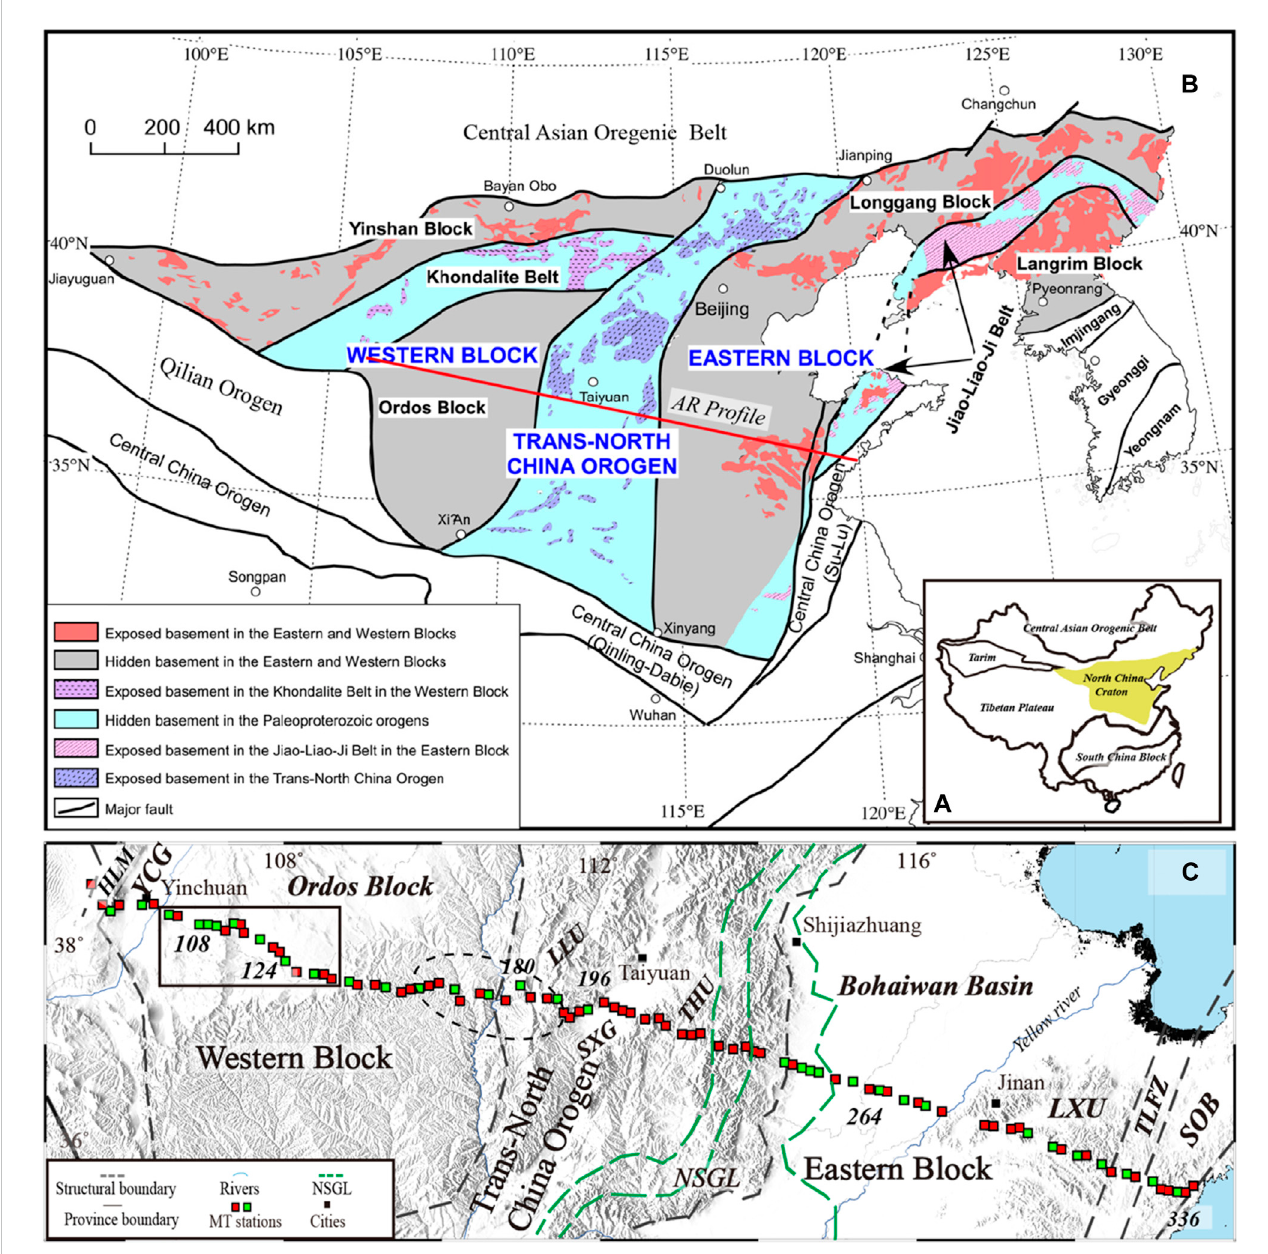
FIGURE 1 (A) TectonicmapofChinashowingMajorunitsandthelocationoftheNorthChinaCraton. (B) TectonicsubdivisionoftheNorthChinaCratonafter(Zhao and Cawood, 2012). Red line: the MT pro fi le (AR) used in this paper. (C) The location of MT stations of the AR pro fi le and tectonic subdivision of the primary units of the North China Craton. Black dashed ellipse: MT stations located in the southern Ordos Block. Black rectangle: the fl at terrane balanced by